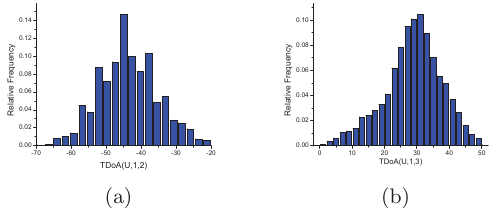
Figure 7: TDoA Histograms